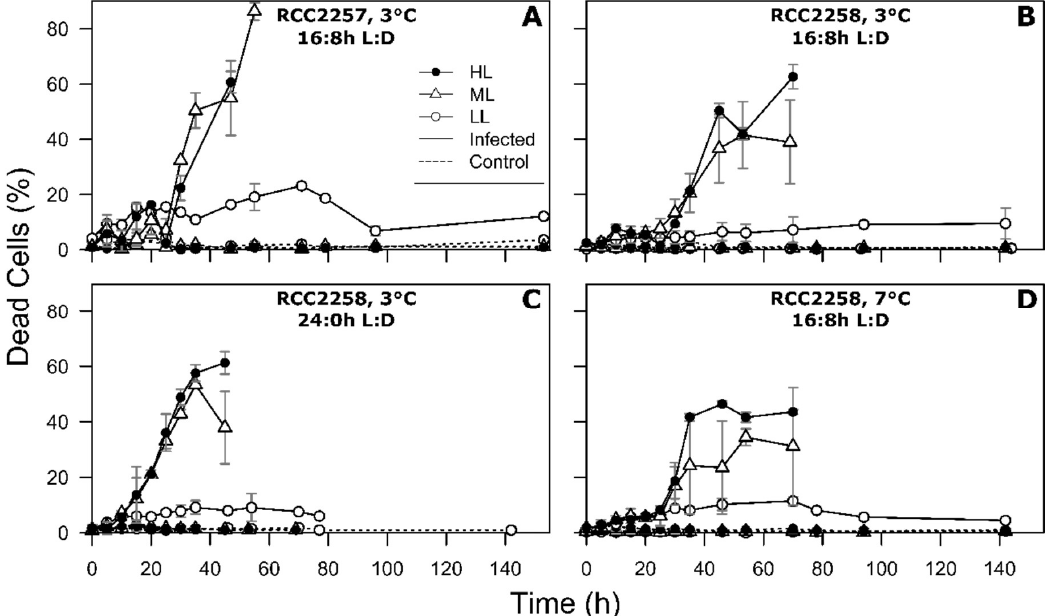
Figure 3. Temporal dynamics of percentage of dead cells for non-infected controls (dashed lines) and MpoV-45T infected Micromonas polaris RCC2257 ( A ) and RCC2258 ( B – D ), cultured at 3 °C ( A - C ) and 7 °C ( D ), with a 16:8 h ( A , B , D ) and 24:0 h ( C ) light:dark (L:D) cycle and different light intensities (LL, ML and HL, i.e. respectively, 5, 60 and 160 μmol quanta m -2 s -1 ). LL at 3 °C and 16:8 h L:D cycle and ML at 7 °C and 16:8 h L:D have n = 4, ML at 3 °C and 16:8 h L:D has n = 6, all the other conditions have n = 2. Error bars represent standard deviation and r.u. stands for relative units .